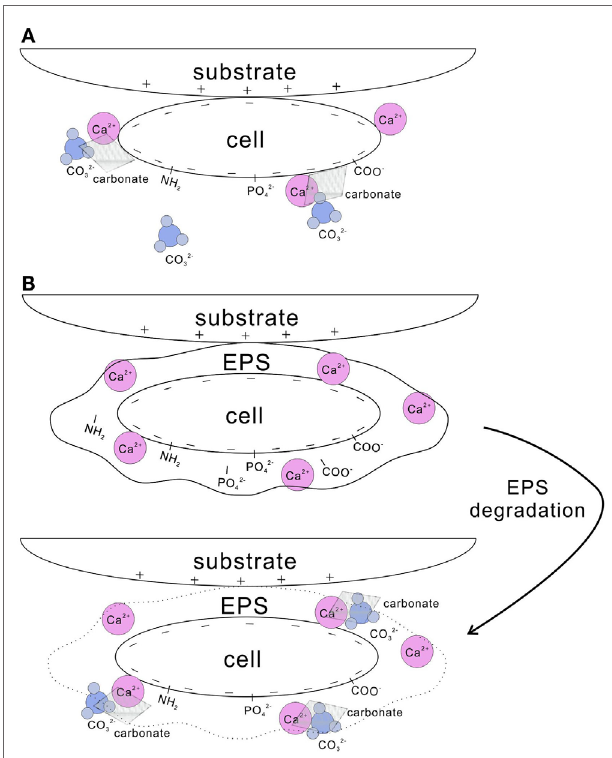
FiGURe 2 | Nucleation of carbonate crystals on microbial surfaces. (A) Cell wall with negatively charged functional groups, such as carboxyl, phosphate, and amine groups, adsorbs Ca 2 + . Subsequently, carbonates precipitates on the cell surface when carbonate species are available. (B) EPS-containing functional groups trap a large amount of Ca 2 + . After EPS is degraded, high concentration of Ca 2 + is reached locally and results in the precipitation of calcium carbonate in the presence of carbonate species. In addition, cells with negatively charged surface tend to attach to substrates with positive